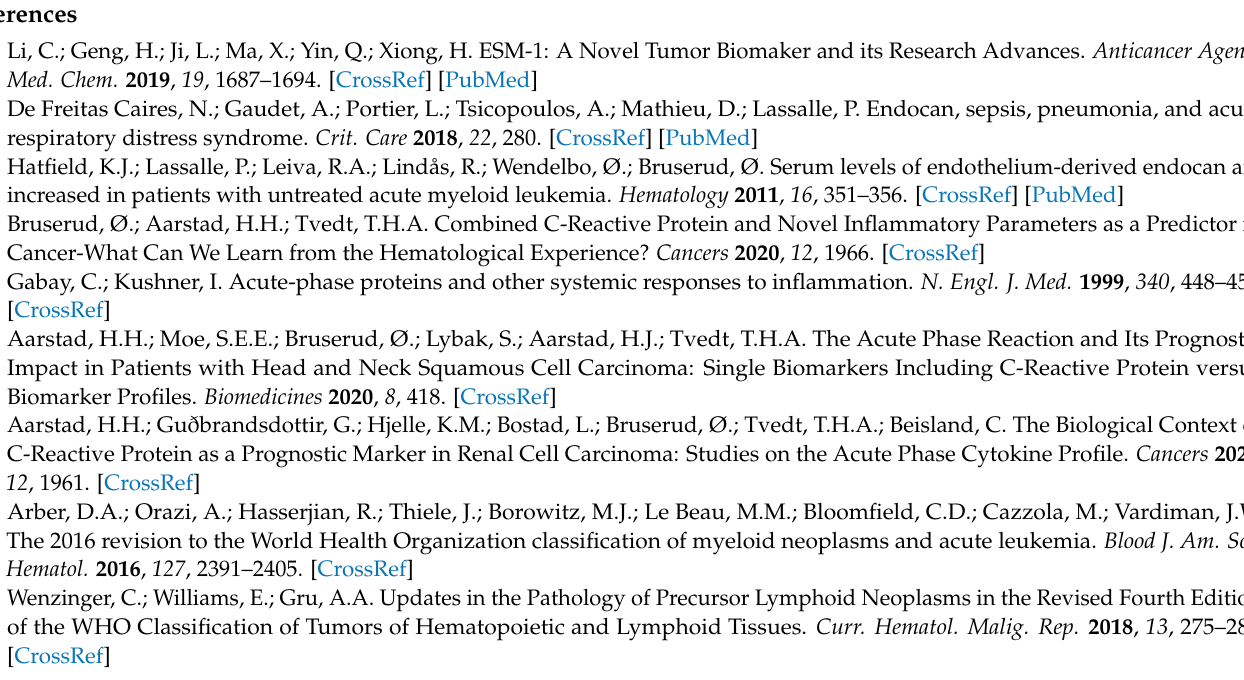
Table S2: A summary of systemic endocan levels in human